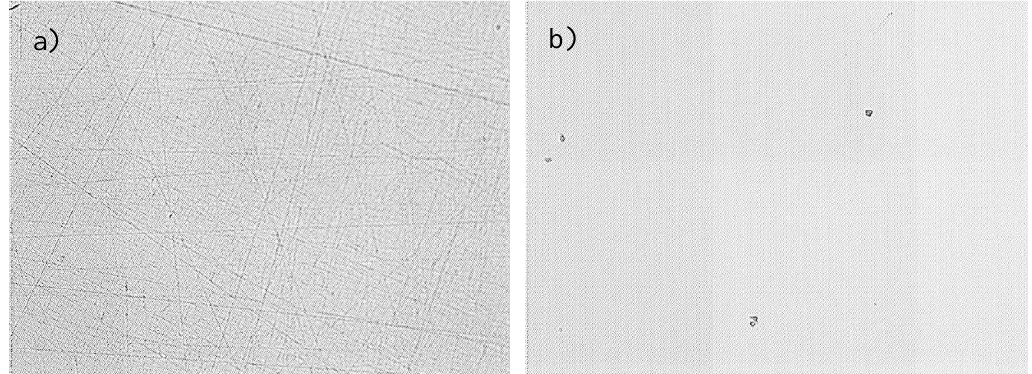
Figure 5. The optical microscopy images of the samples: ( a ) MDP [001], ( b ) CMP [001]. Magnification = 200x.